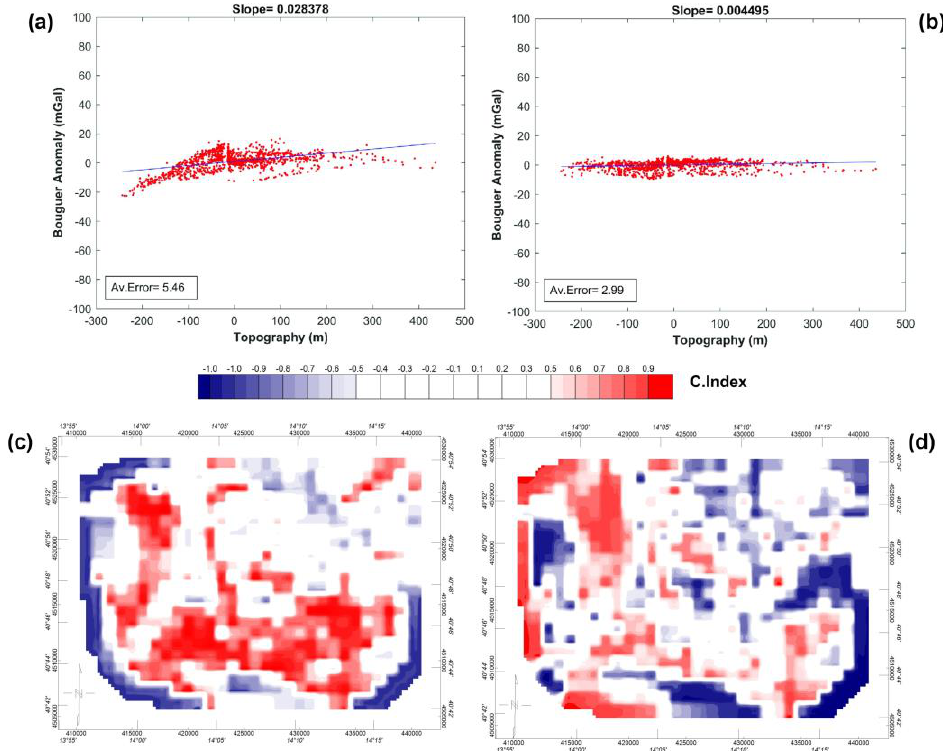
Figure 7. Scatter plots of the CBA vs. topography elevation ( a ) and regional de-trended CBA field vs. topography elevation. ( b ). Distribution of the correlation coefficients of the CBA field vs. topography elevations ( c ) and of the regional de-trended CBA field vs. topography elevations ( d ). See text for explanation.